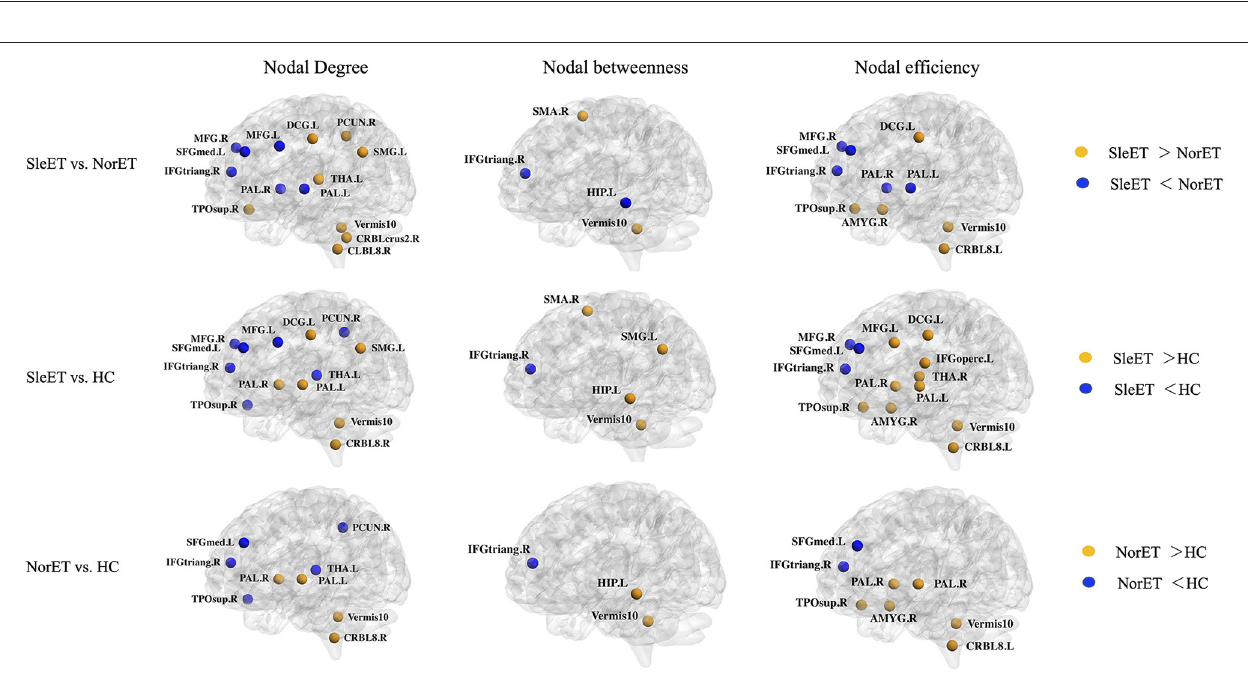
FIGURE 1 | Global gray matter network properties differed significantly among the SleET, NorET, and HC groups. Black asterisks indicate significant differences in the post-hoc comparisons between SleET and NorET. ET, essential tremor; SleET, ET with poor sleep quality; NorET, ET with normal sleep quality; HC, healthy control; AUC, area under the curve; E glob , global efficiency; E loc , local efficiency; C p , clustering coefficient; L p , characteristic path length; γ , normalized clustering coefficient; σ , small-worldness.